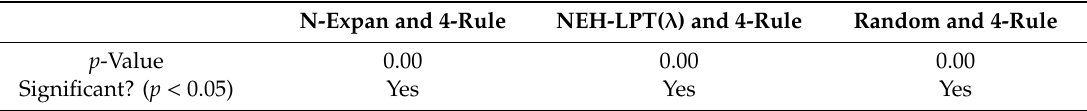
Table 2. The hypothesis tests of 4-Rule with other heuristic schemes.